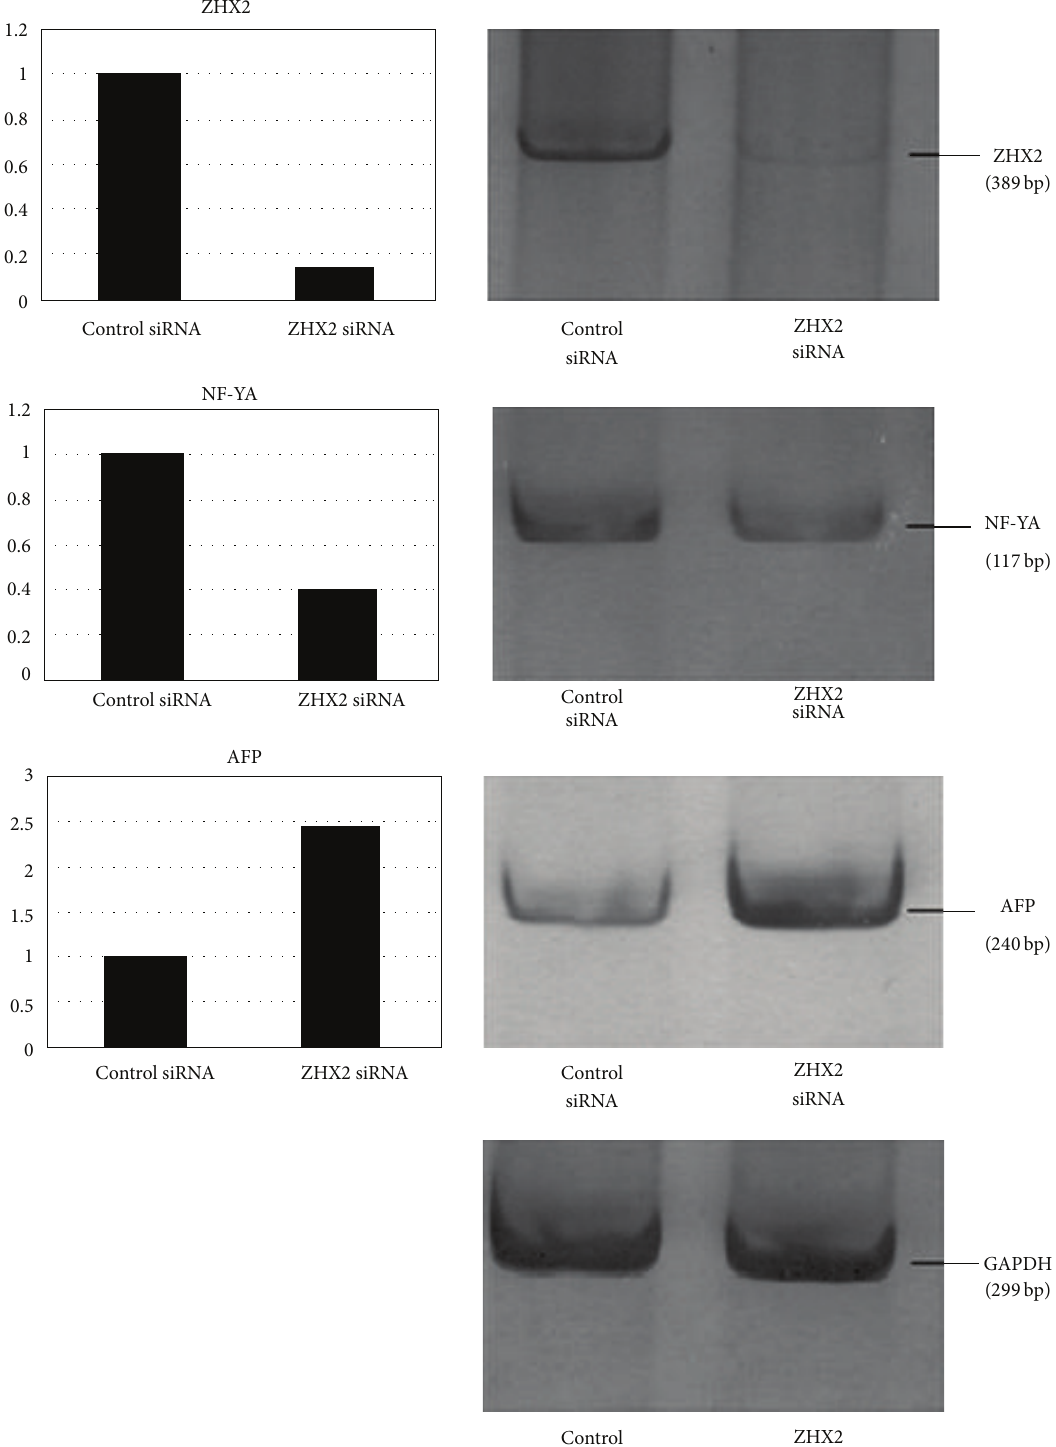
Figure 2: expression of zinc fingers and homeoboxes 2 (ZHX2), nuclear factor-YA (NF-YA), and alpha-fetal protein (AFP) mRNA in HepG2 cells after siRNA transfection. The target mRNA expression was detected by RT-PCR analysis. The expression of glyceraldehyde-3-phosphate dehydrogenase (GAPDH) served as an internal control. The amounts of mRNA in the ZHX2 siRNA-treated cells were compared to those of control cells. After siRNA transfection, ZHX2 mRNA expression (389bp) was decreased by 85%, NF-YA mRNA expression (117bp) was reduced by 60%, and AFP mRNA expression (240 bp) was increased by